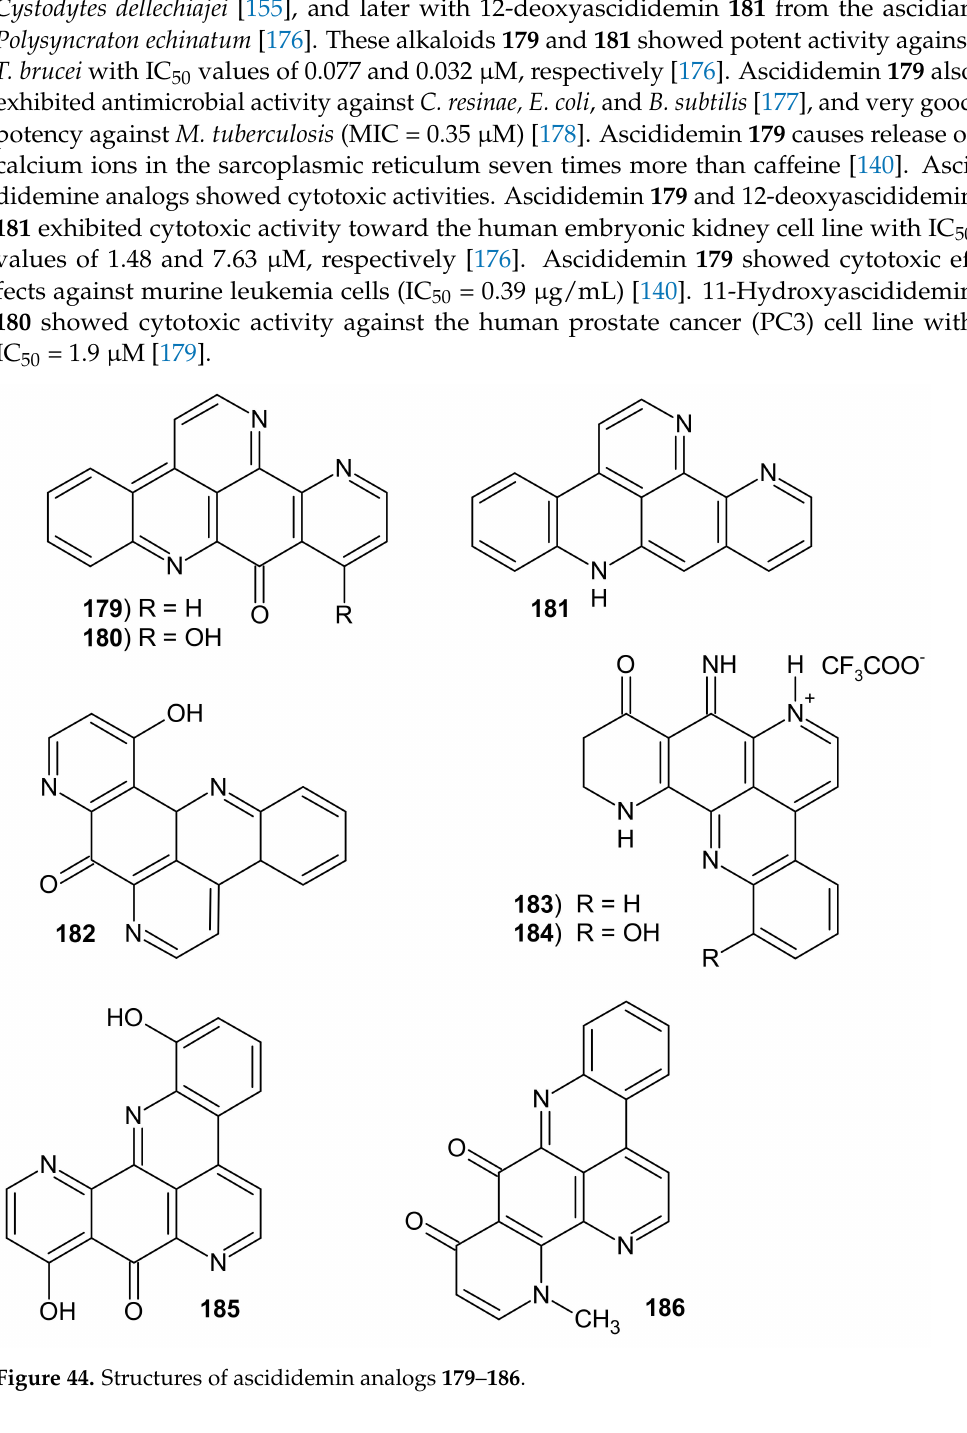
Ascididemin analogs also possess a pyridine ring fused to the pyridoacridine scaffold (Figure 44). Ascididemin 179 was isolated from the tunicate Didemnum sp. and the ascidian